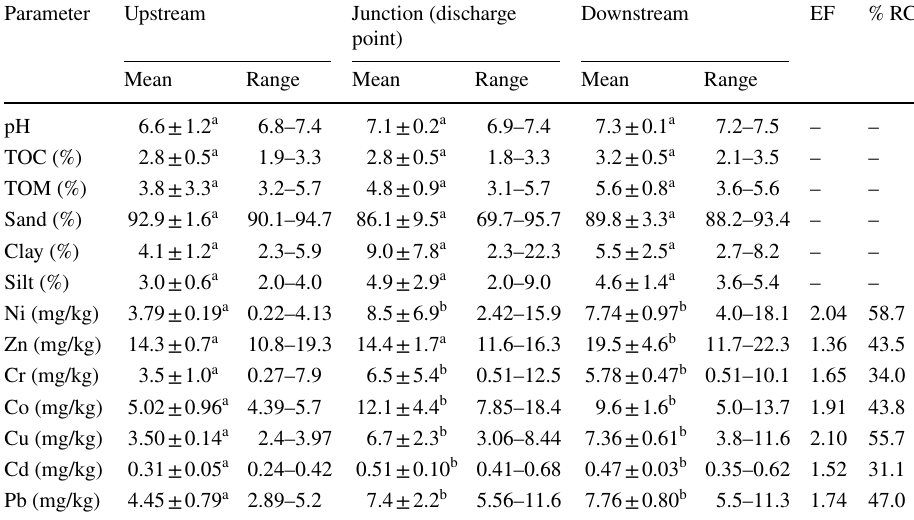
Within a row, average concentration with different superscripts (a, b) differs